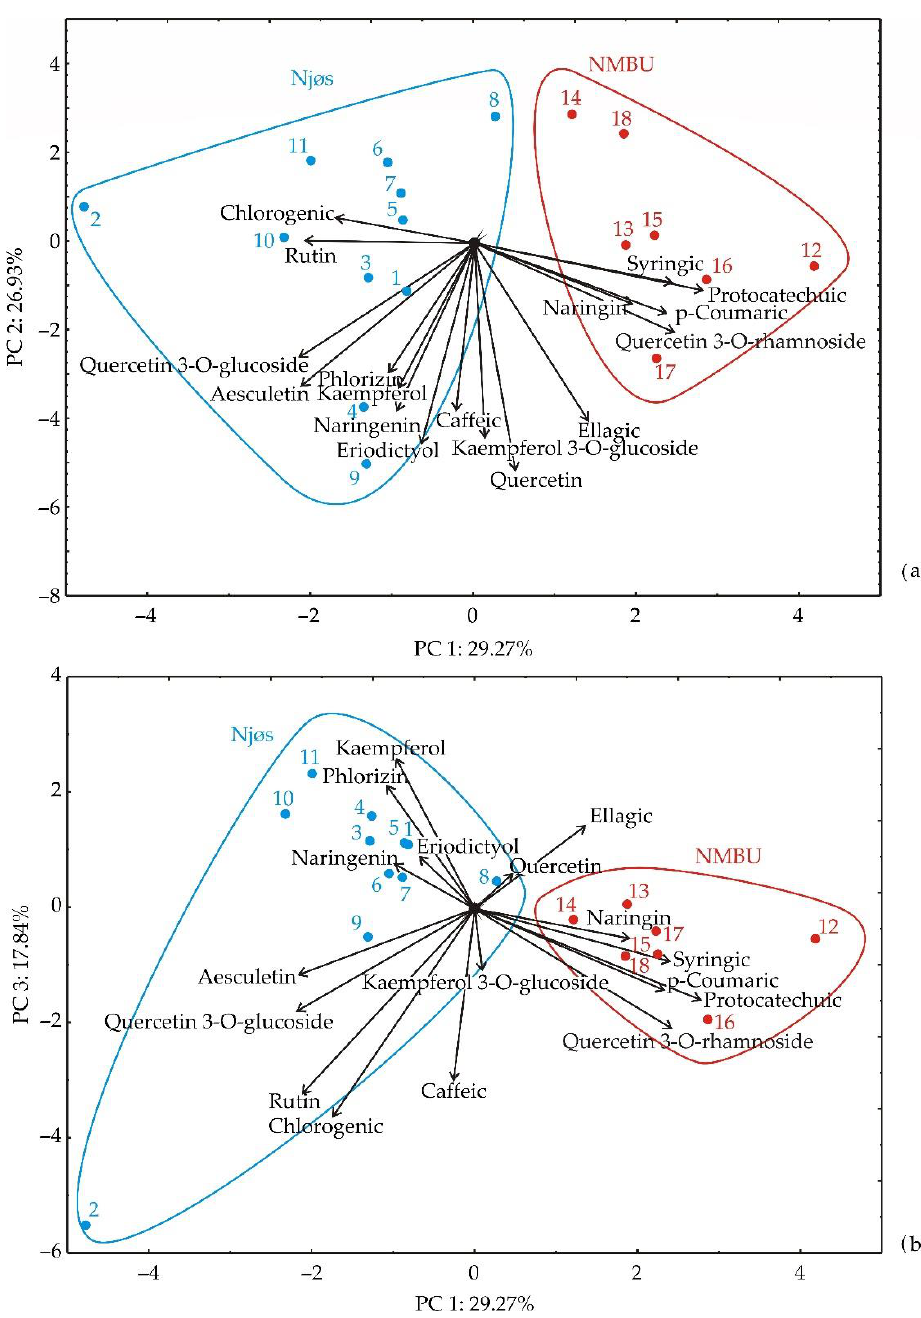
Figure 5. PCA ordination of phenolic content variables: ( a ) projection in PC1-PC2 plane; ( b ) projection in PC1-PC3 plane.